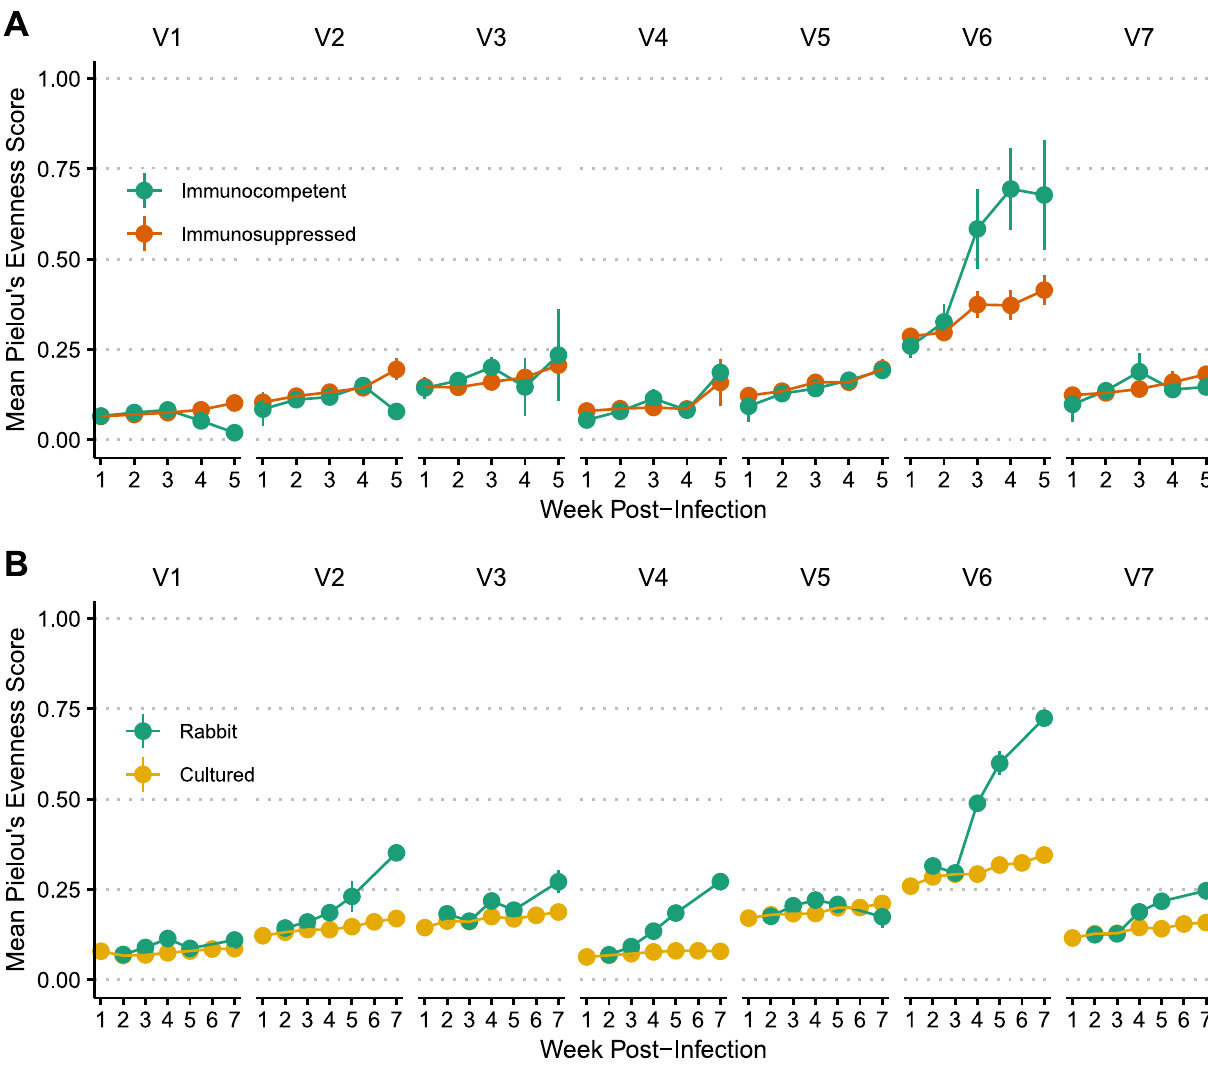
Fig 4. Longitudinal allelic diversity of samples passaged in (A) immunosuppressed vs. immunocompetent rabbits and (B) immunocompetent rabbit vs. in vitro culture system. Data are separated by variable region. Dots represent the mean Pielou’s evenness score across different color-coded groups, with lines marking the standard